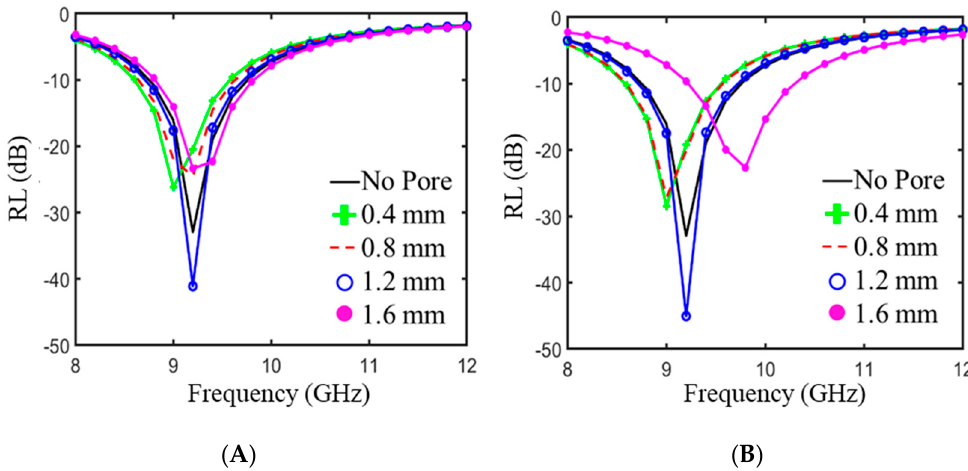
Figure 8. Modeled reflection loss for 5%M25 / PLA with thickness of 4 mm and modified with either a single spherical pore ( A ) or a cylindrical pore ( B ). Both plots show the effects of a changing radius. In the case of the cylindrical pore, the height is fixed at 1.8 mm.